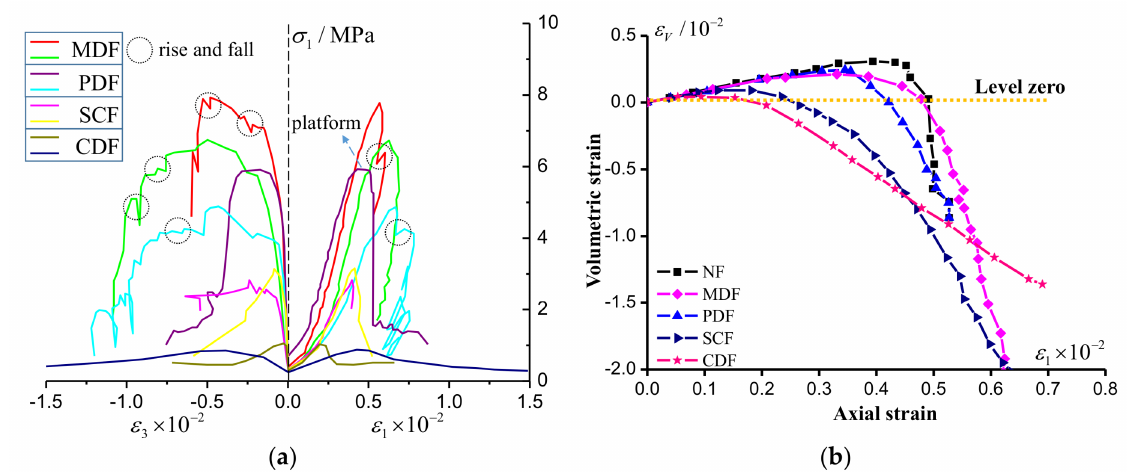
Figure 4. Deformation of fractured coal. ( a ) Complete stress-strain curve. ( b ) Volumetric strain-Axial